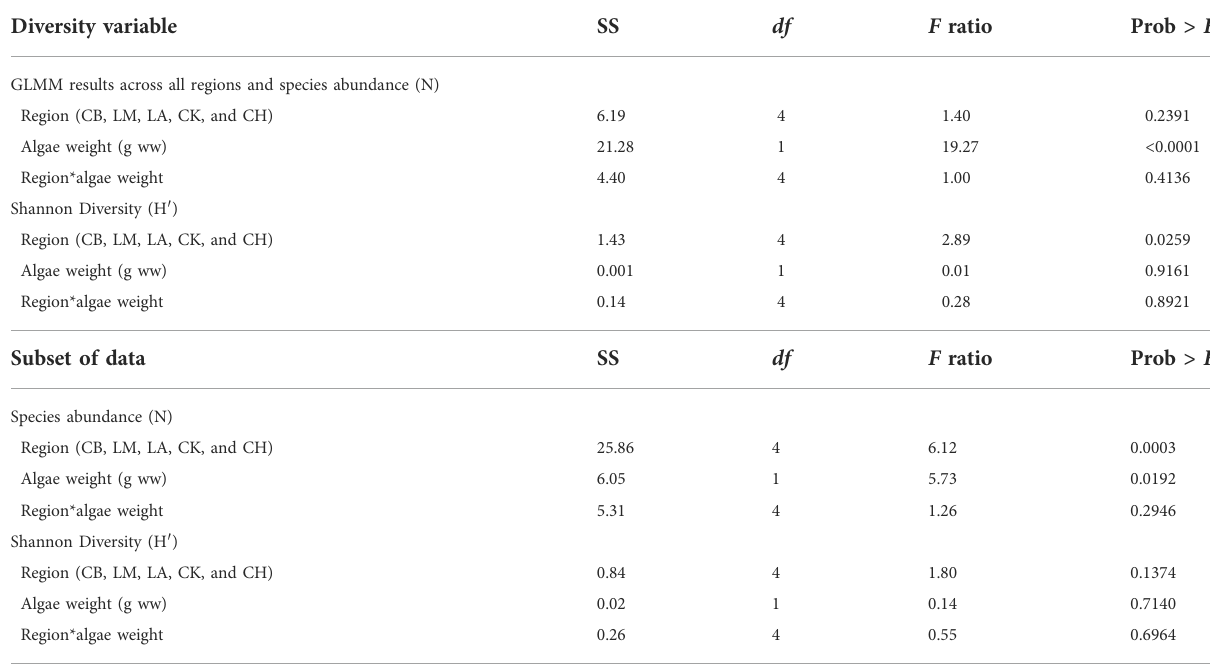
TABLE 1 Animal diversity across region and algae weight. GLMMs were performed in SAS © to compare nekton abundance (N)and diversity (H ’ ) across region (CB, CH,CK, LA, and LM) and algae weight [g wet weight (ww)]. General linear regression models for species abundance across region and algae weight during the summer 2018 sampling season, when seagrass was held constant, was also